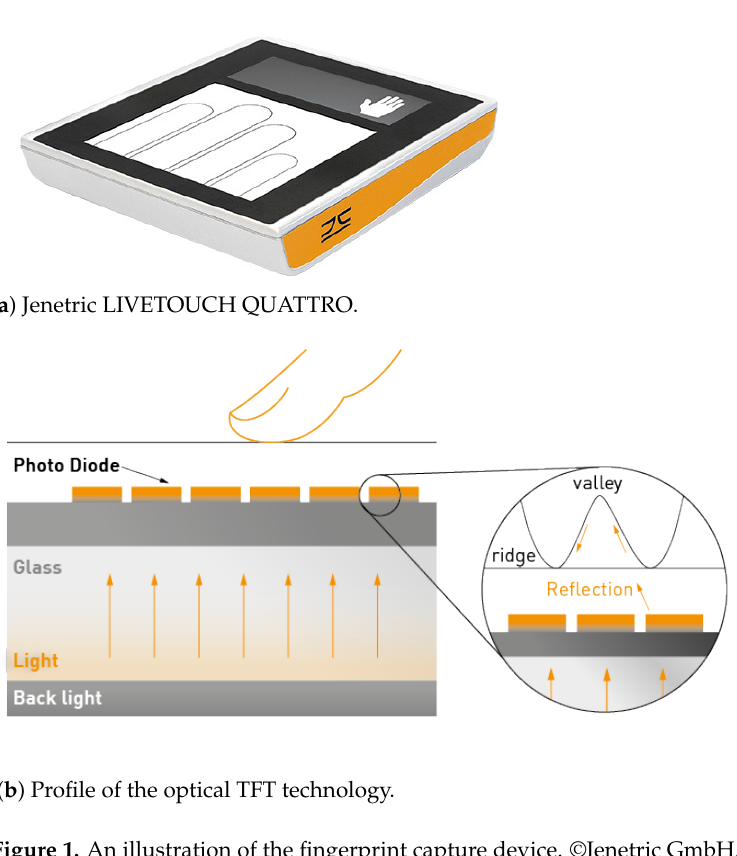
Figure 1. An illustration of the fingerprint capture device. ©Jenetric GmbH.